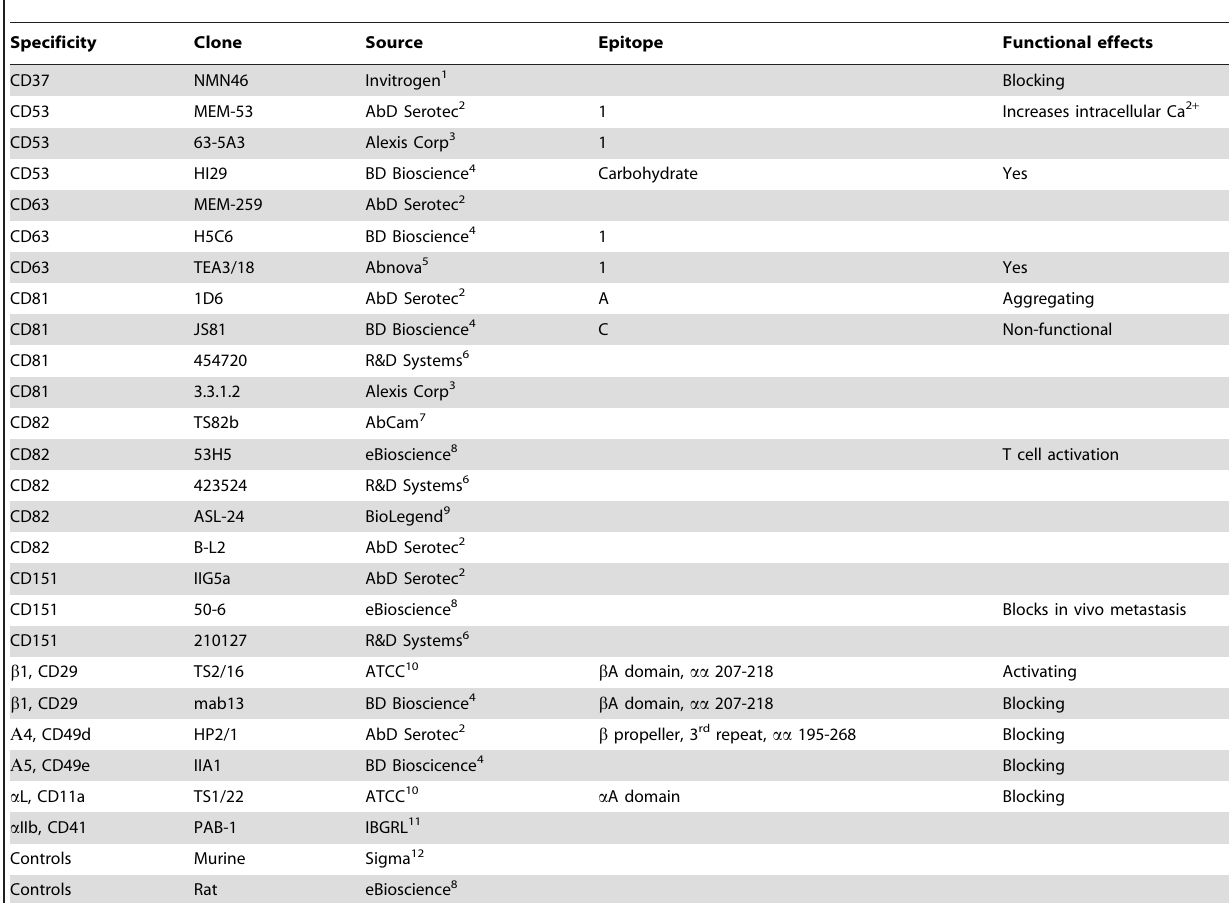
Table 2. Source, epitope location and functional properties of antibodies used for immune precipitation and adhesion assays.